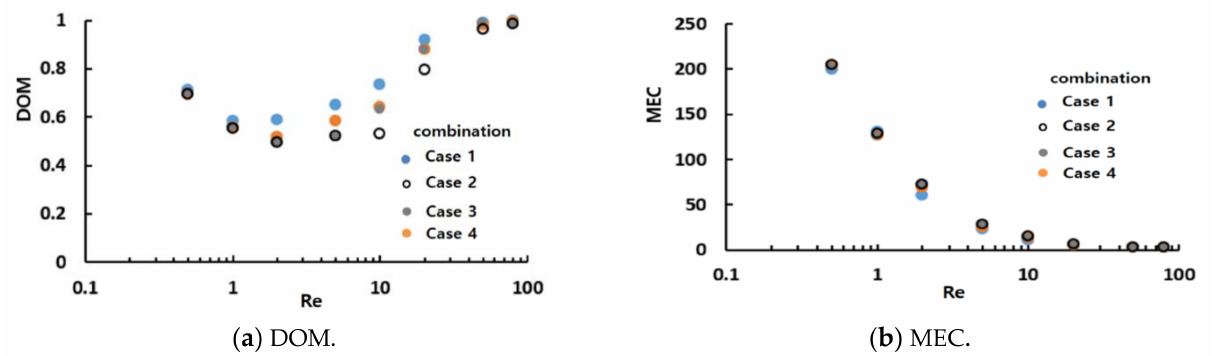
Figure 17. Comparison of the mixing performance of the four combinations.